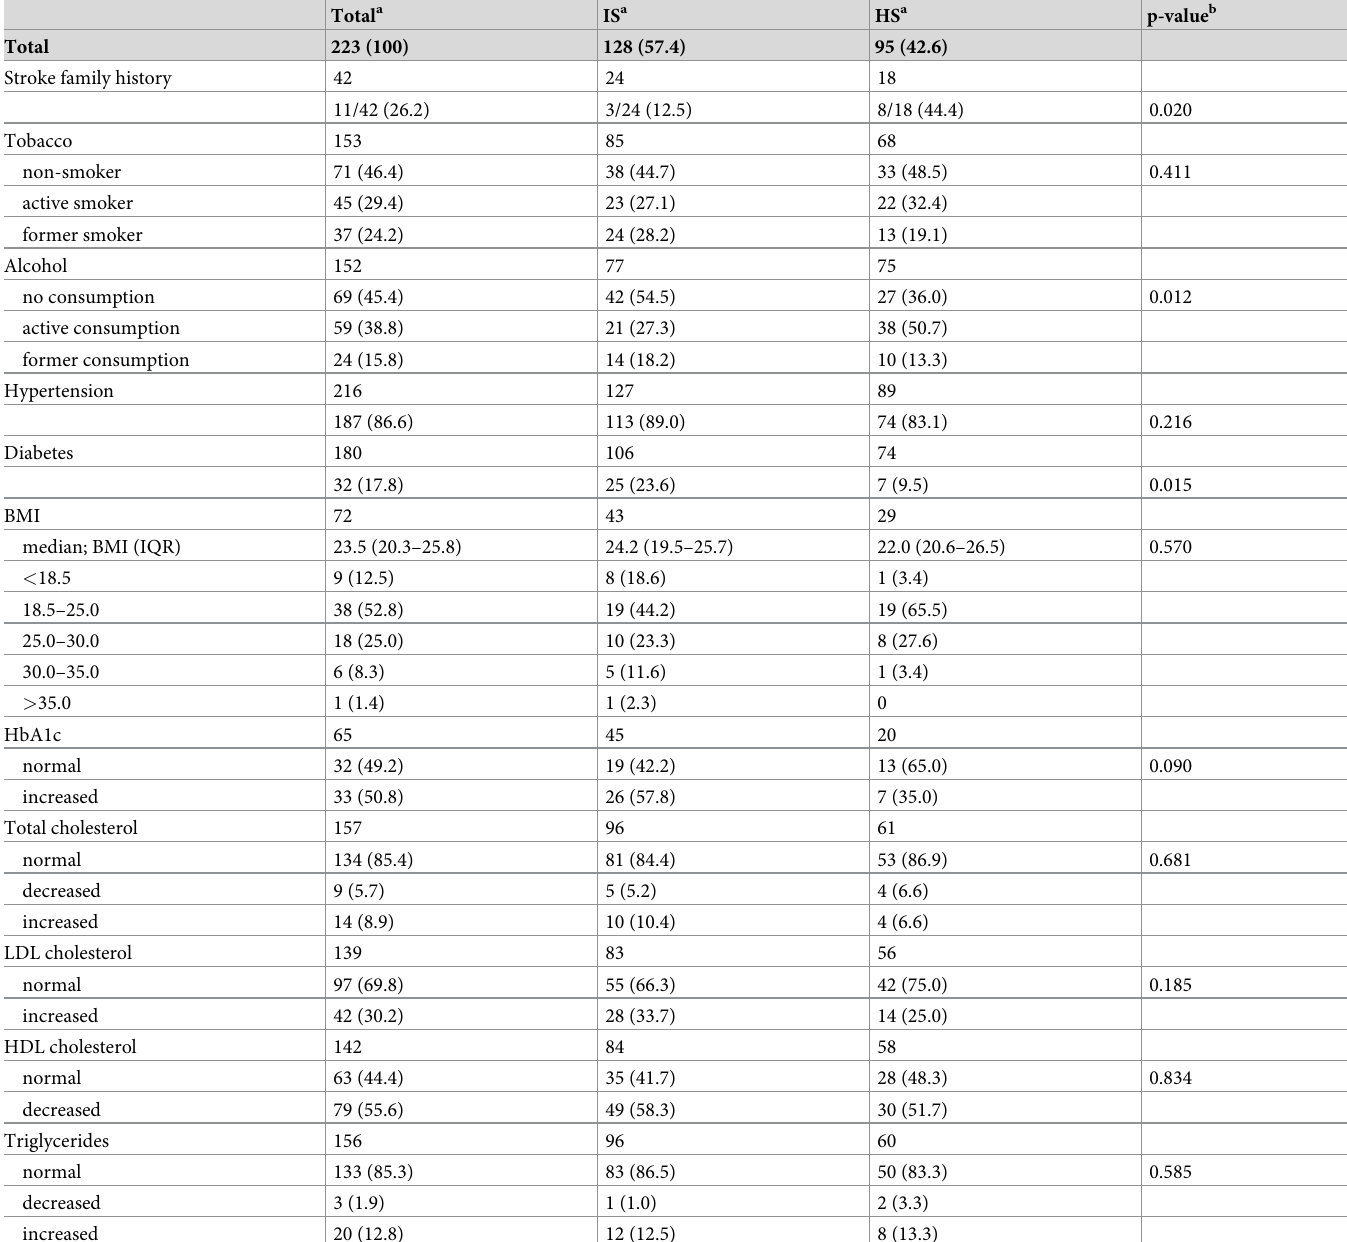
Table 4. Contributing risk factors among patients with ischemic or hemorrhagic